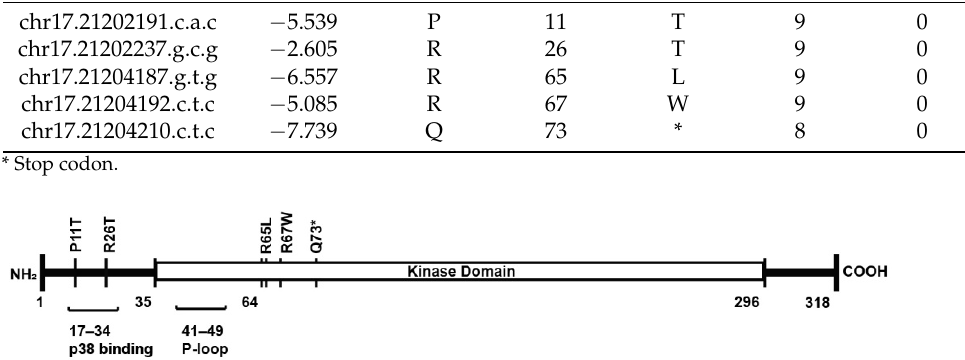
Figure 1. Identification of potential oncogenes involved in ALL. Schematic diagram showing the criteria used to identify ALL variants with a PROVEAN score of less than −2.5. Table 1. Identification of SNPs in the MAP2K3 gene using the OncoMiner Pipeline. MAP2K3 Provean